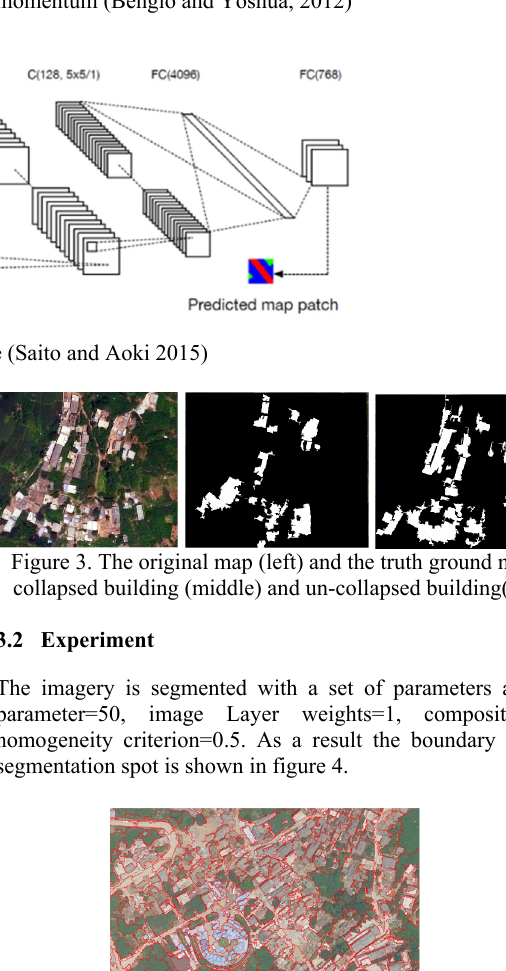
figure 2. The CNN is trained by minimizing the negative log